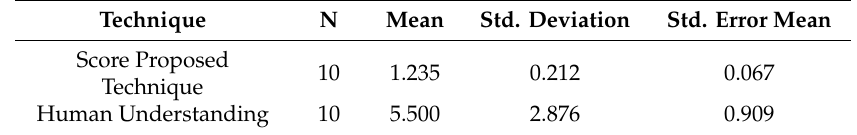
Table 10. Test statistics of t -test (Group Statistics).